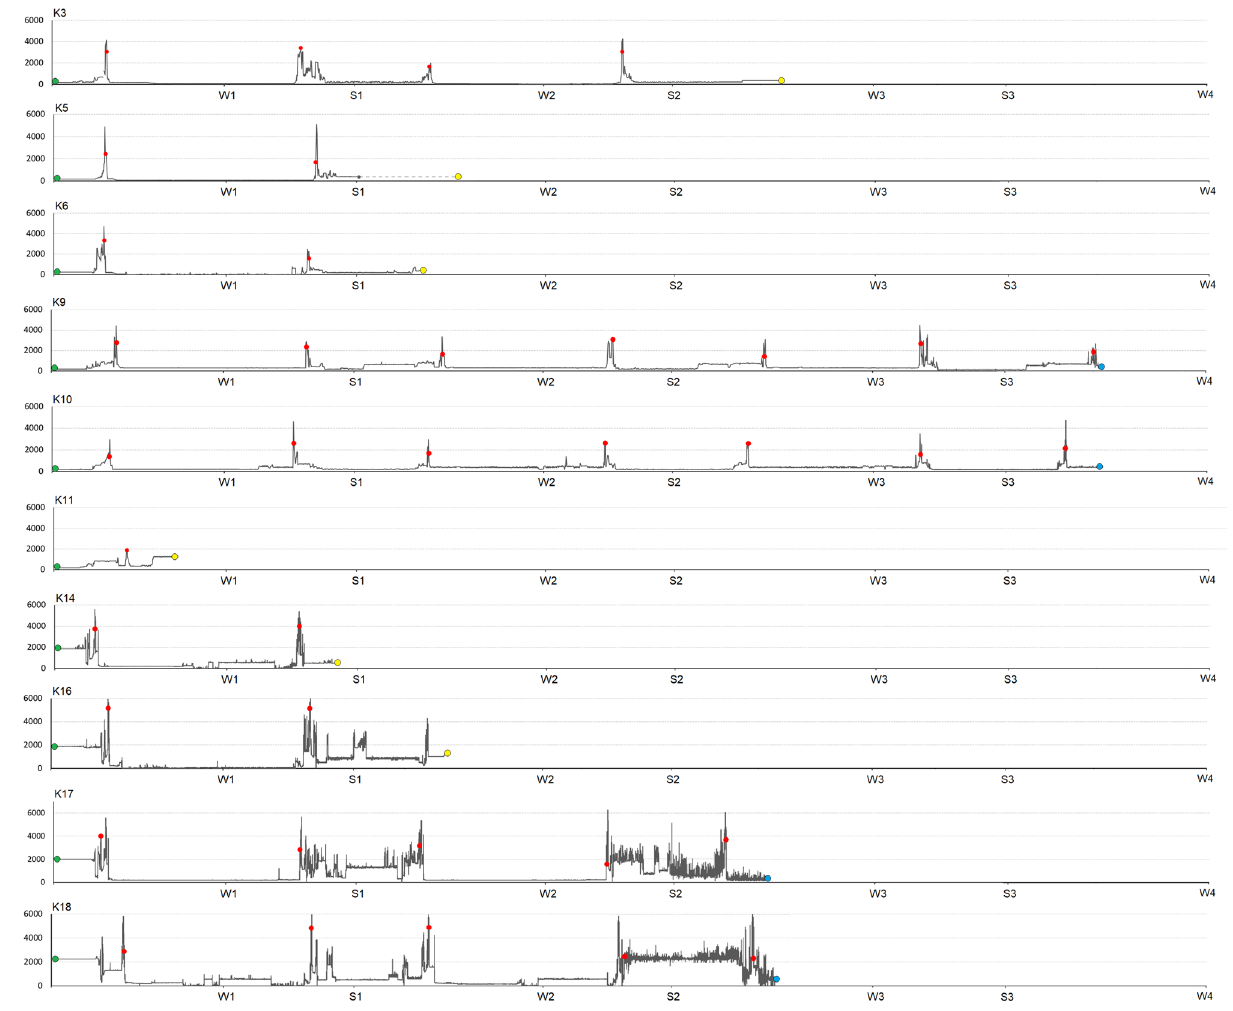
Figure 3. Elevation profile of lifelong journeys of tracked Black Kites. Green dots represent the nest, red dots represent highest roost points during migrations, yellow dots represent the last position collected due to the death of birds or signal loss, blue dots represent the last position collected of living birds. For latitudes in W1, W2, W3 and S1, S2, S3 see Fig.